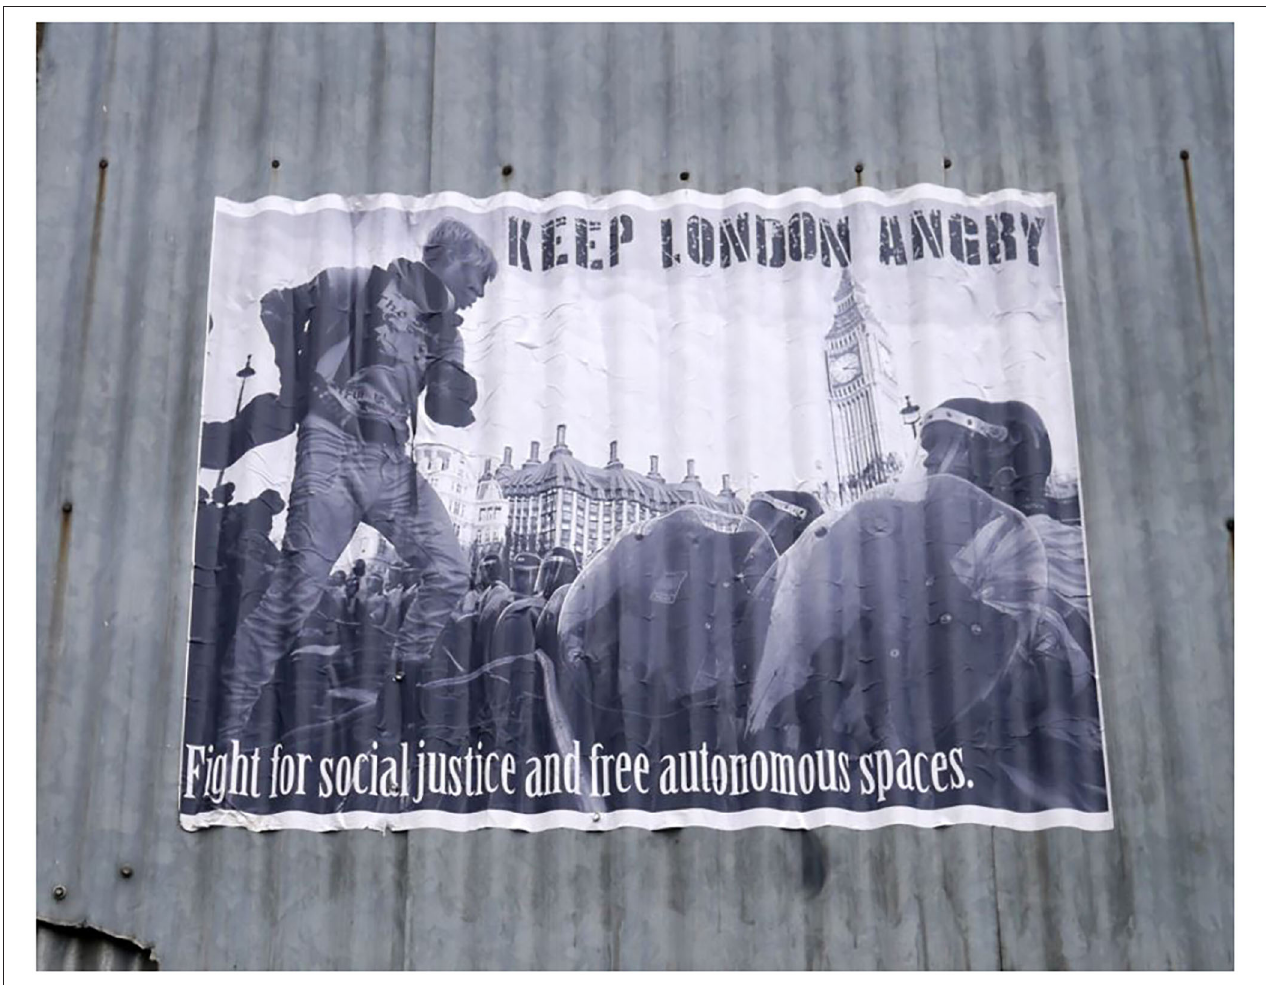
FIGURE 1 | Feel the anger and use